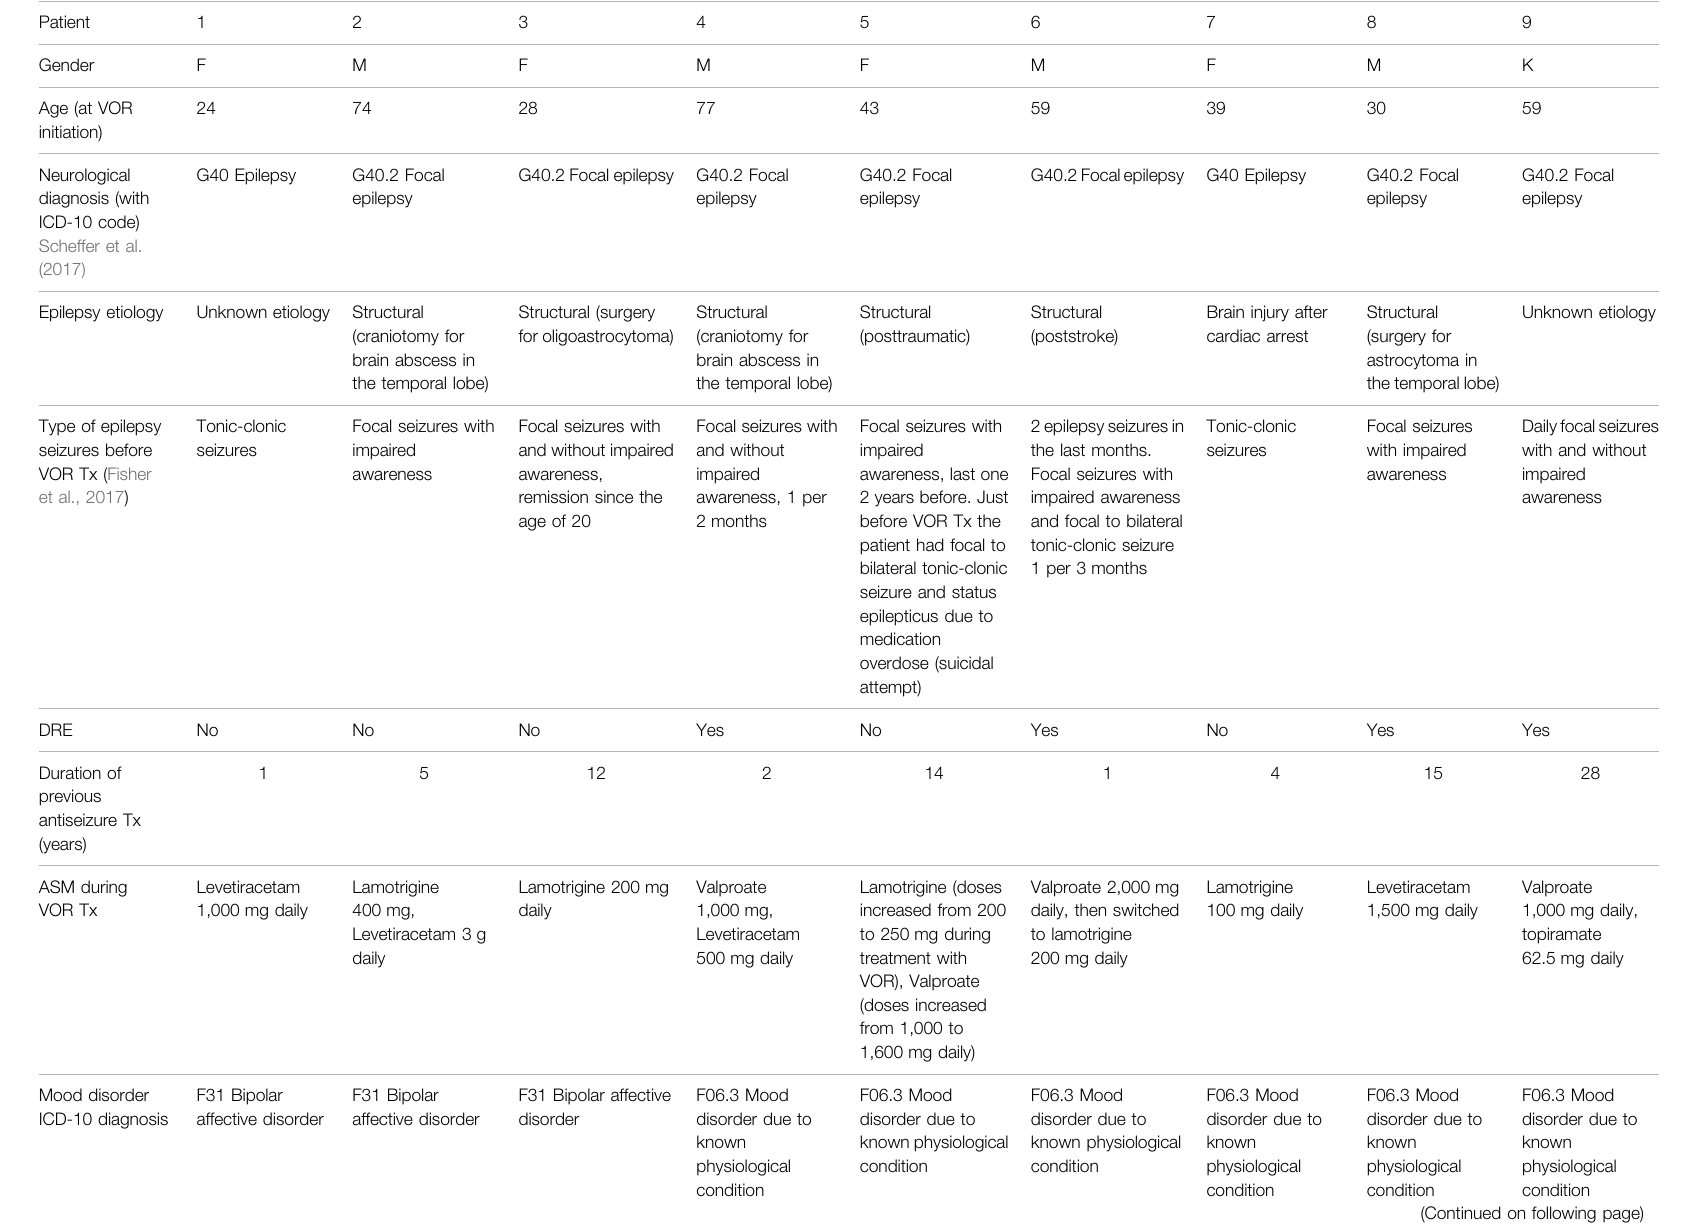
TABLE 1 | Presentation of nine cases of patients with depressive symptoms and epilepsy treated with vortioxetine.